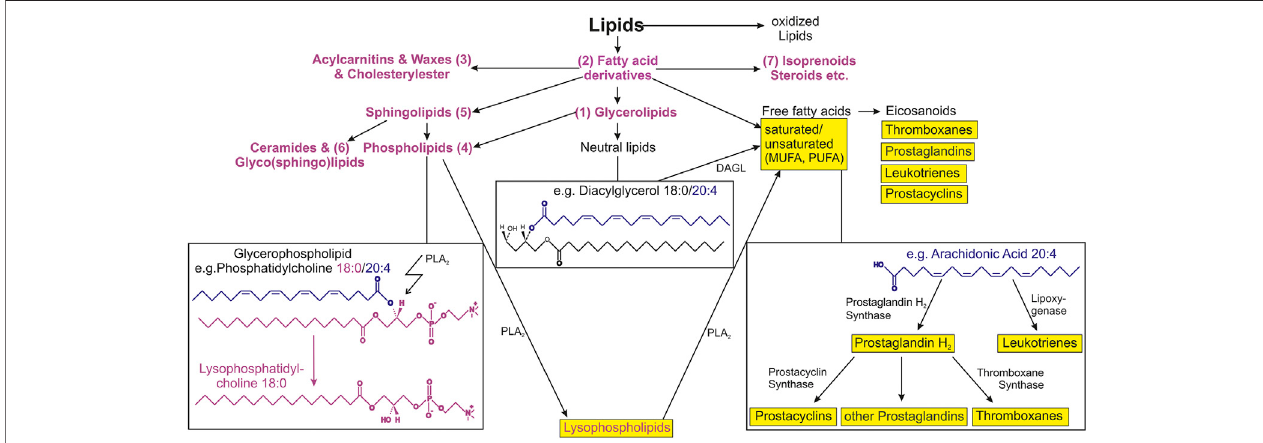
FIGURE 1 | Schematic overview of lipid subclasses and connections to selected lipid metabolic pathways. Lipids are very diverse and complex biological compounds. The arrows illustrate similarities and connection between lipid categories, main classes, subclasses and substructures. Seven categories are shown that have been relevant in aging-associated studies. Examples for phospholipids and neutral lipids (as a subclass of glycerophospholipids) are shown in the left and middle box, respectively. Theright boxshows thesimpli fi edarachidoniccascadeasexamplefor theeicosanoid production from freefatty acids.Importantlipidmediators that are known to be involved in in fl ammatory processes are shown in yellow. Abbreviations: PLA 2 , phospholipase A 2 ; MUFA, monounsaturated fatty acid; PUFA, polyunsaturated fatty acid; DAGL, diacylglycerol lipase.